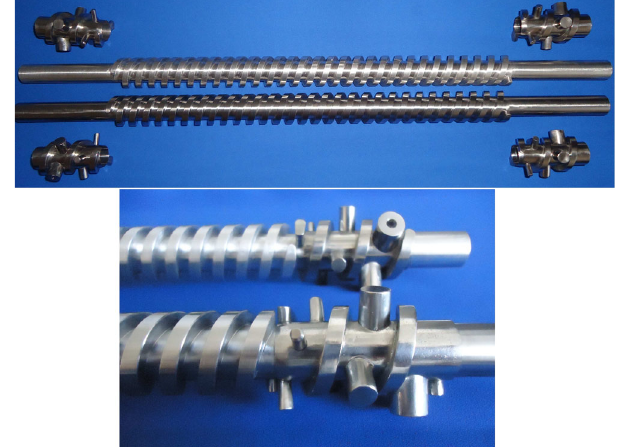
FIG. 5. Top: Al and 1020 steel, 20 mm-period prototype HSCU mandrels with the DMLS turn-around structures not installed. Bottom: One end of the prototypes with the turn-around struc- tures installed.